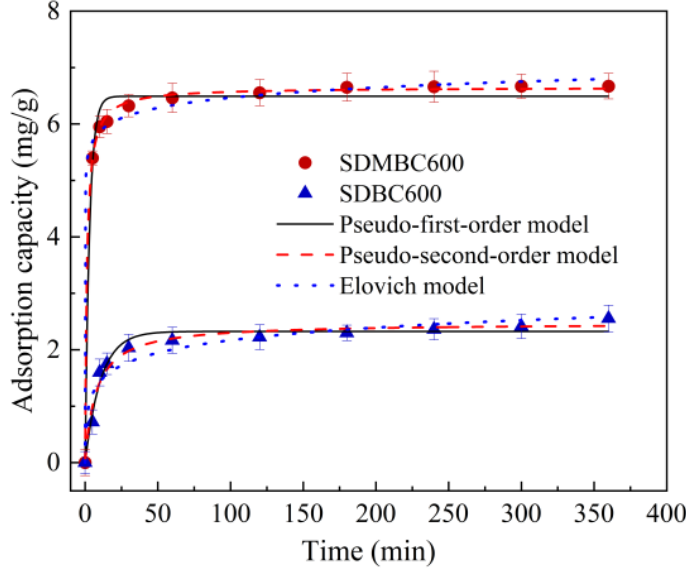
Figure 2. The adsorption kinetics of diuron by SDBC600 and SDMBC600 (5 mg/L diuron, 0.075 g SDMBC600, t = 0–360 min). Table 1. Adsorption kinetic parameters for diuron by SDBC600 and